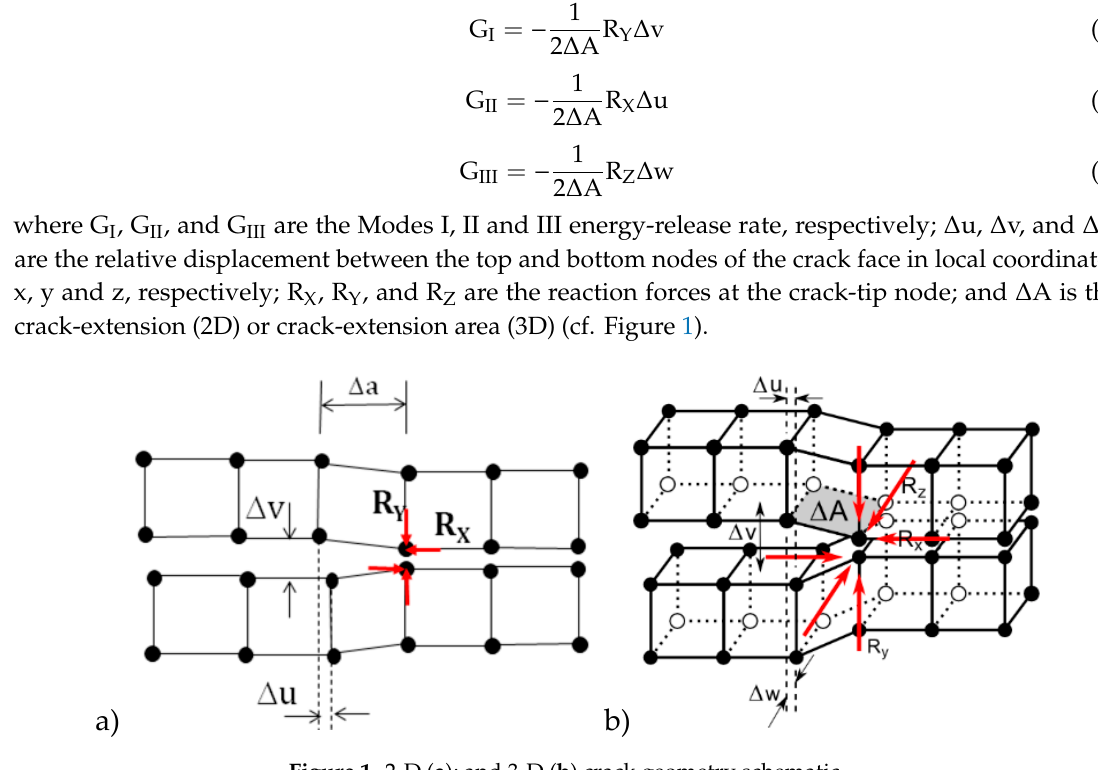
Figure 1. 2-D ( a ); and 3-D ( b ) crack geometry schematic.